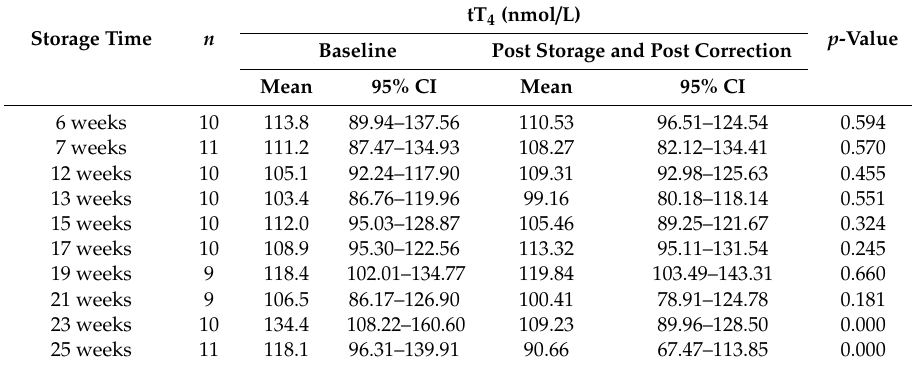
Table 2. Mean thyroxine concentrations at baseline and corrected by 10% after storage. Storage